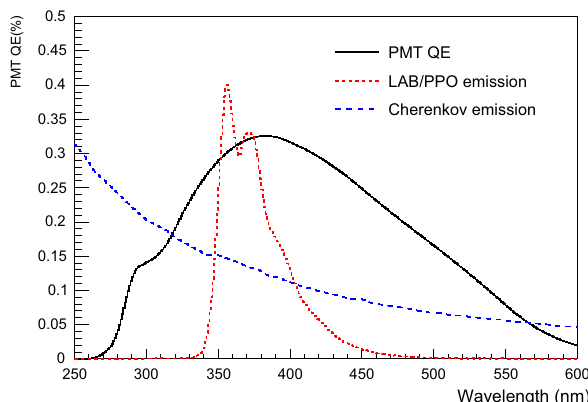
Fig. 6 ShapeoftheQEcurveusedforHamamatsuR11780HQEPMTs along with the Cherenkov and scintillation emission spectra. The nor- malization for the emission spectra is arbitrary